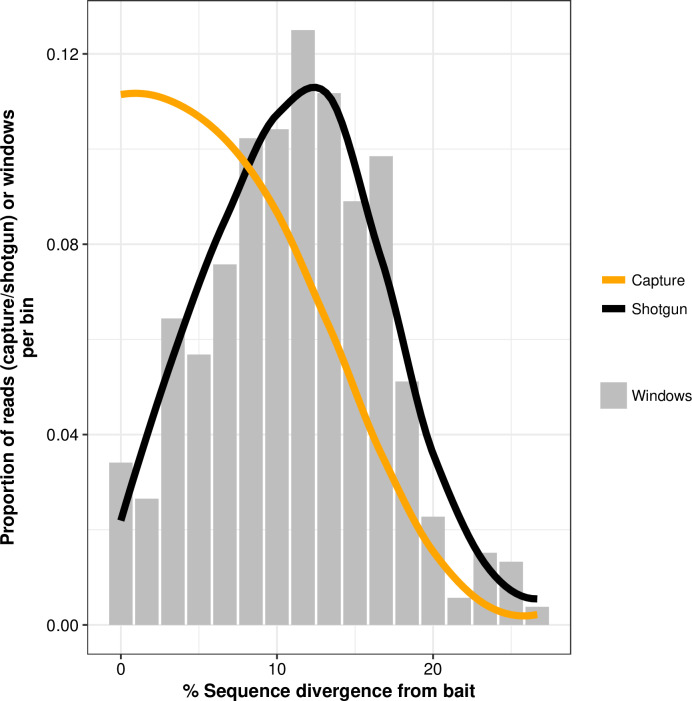
Impact of sequence divergence on capture.Impact of sequence divergence between bait and target on coverage in 60 bp sliding windows (step size of 30 bp). The proportion of the number of windows per sequence divergence bin is given by the grey bars; trendlines (loess smooth regression) for the proportion of unique mapped reads per sequence divergence bin are shown separately for captured libraries (orange) and the shotgun library (black). The shotgun library shows no bias towards/against windows with high or low divergence, whereas the capture libraries show a very clear bias towards high identity windows.